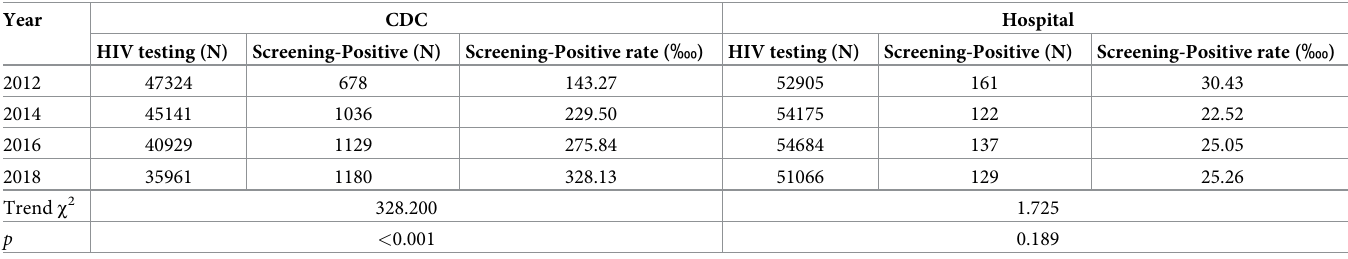
Table 4. Number and rate of HIV screening-test among population in